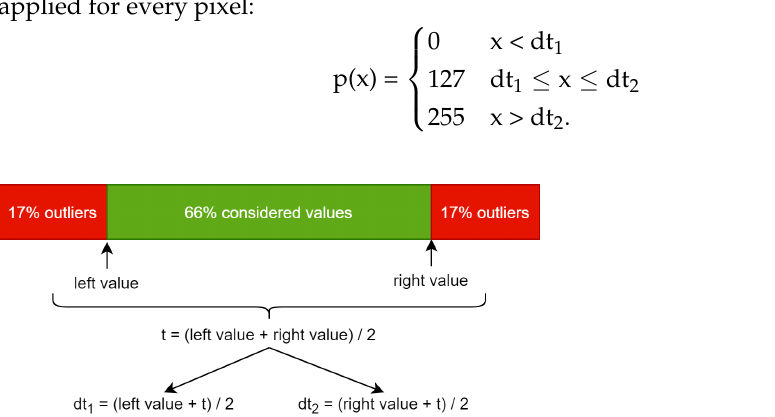
convert the grayscale image to black–gray–white using the following function, which is applied for every pixel: